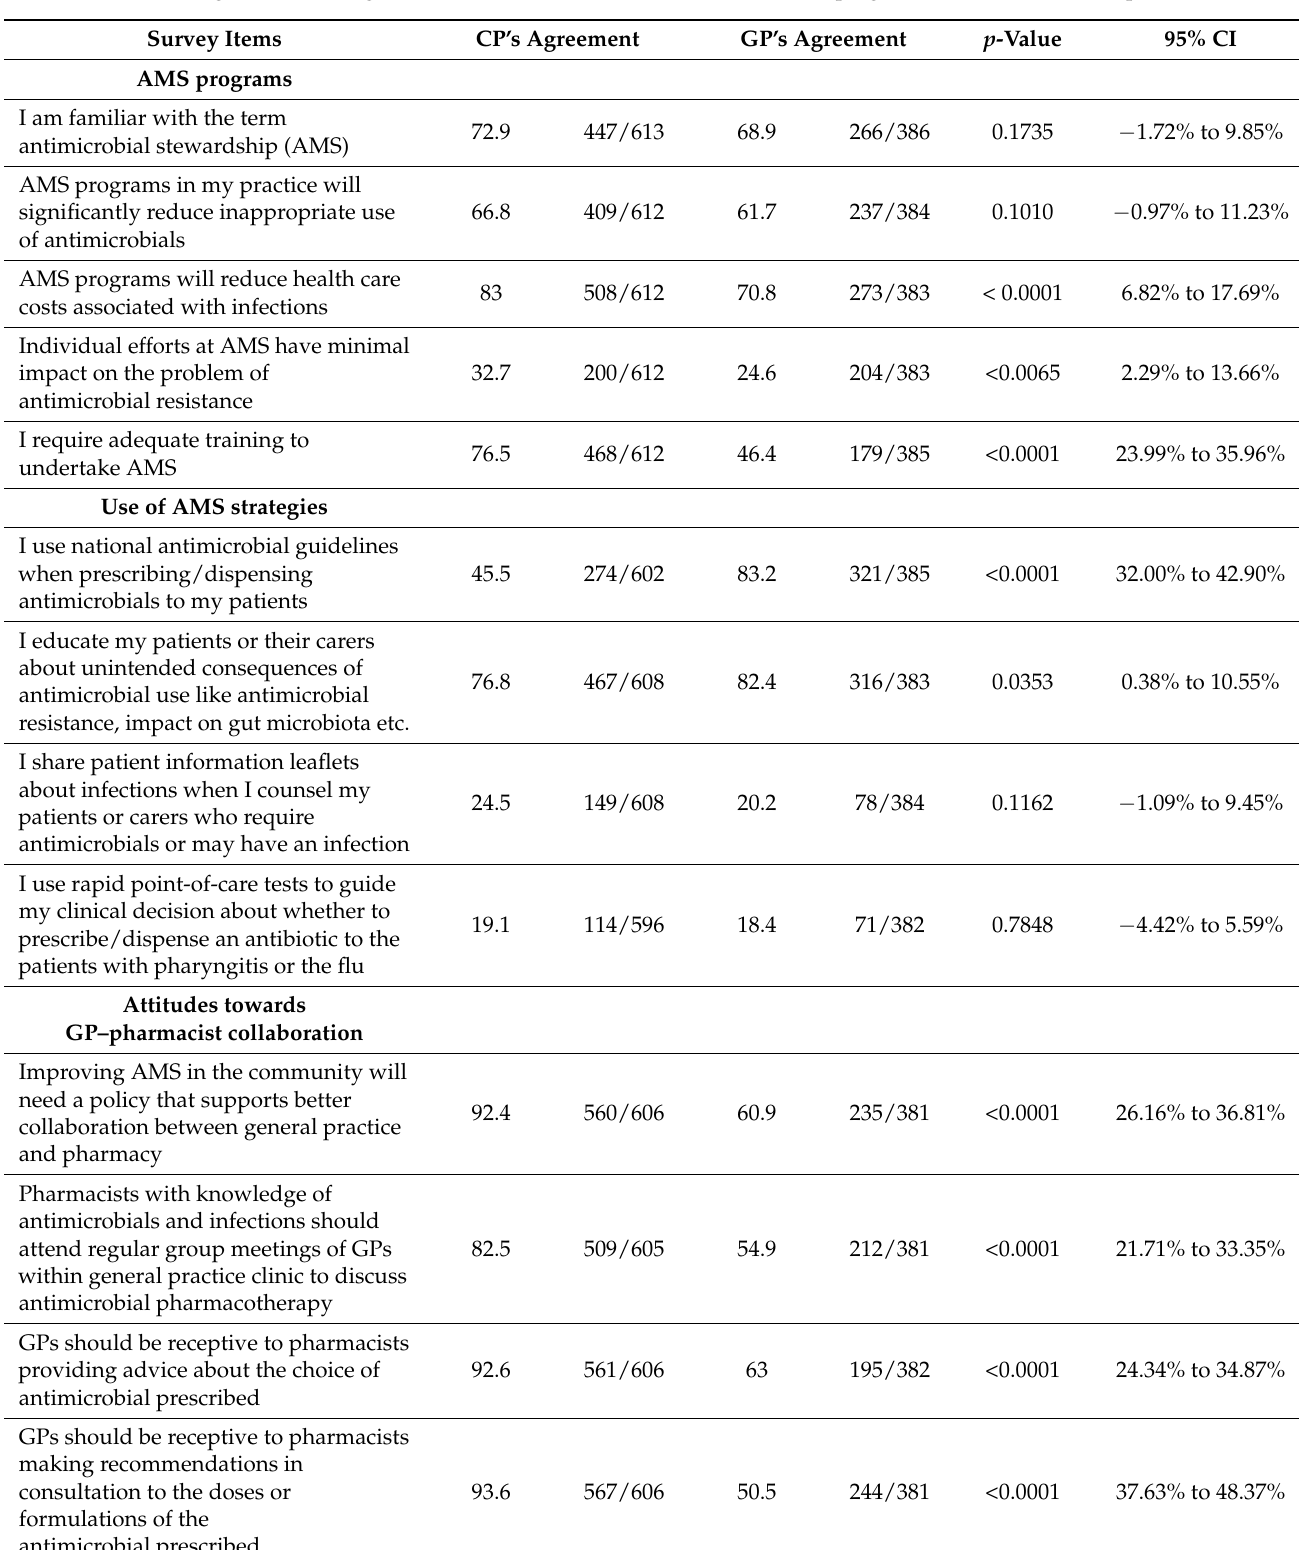
Table 2. Convergence and divergence in the attitudes of GPs and CPs about AMS programs and collaborative implementation. Survey